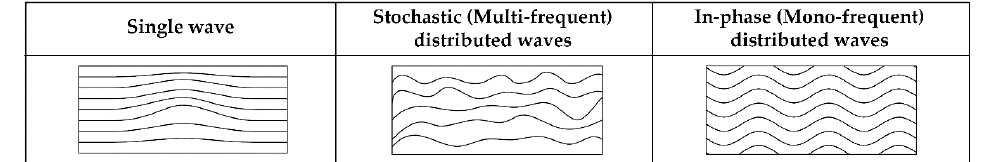
Figure 28. Single vs. distributed waviness.